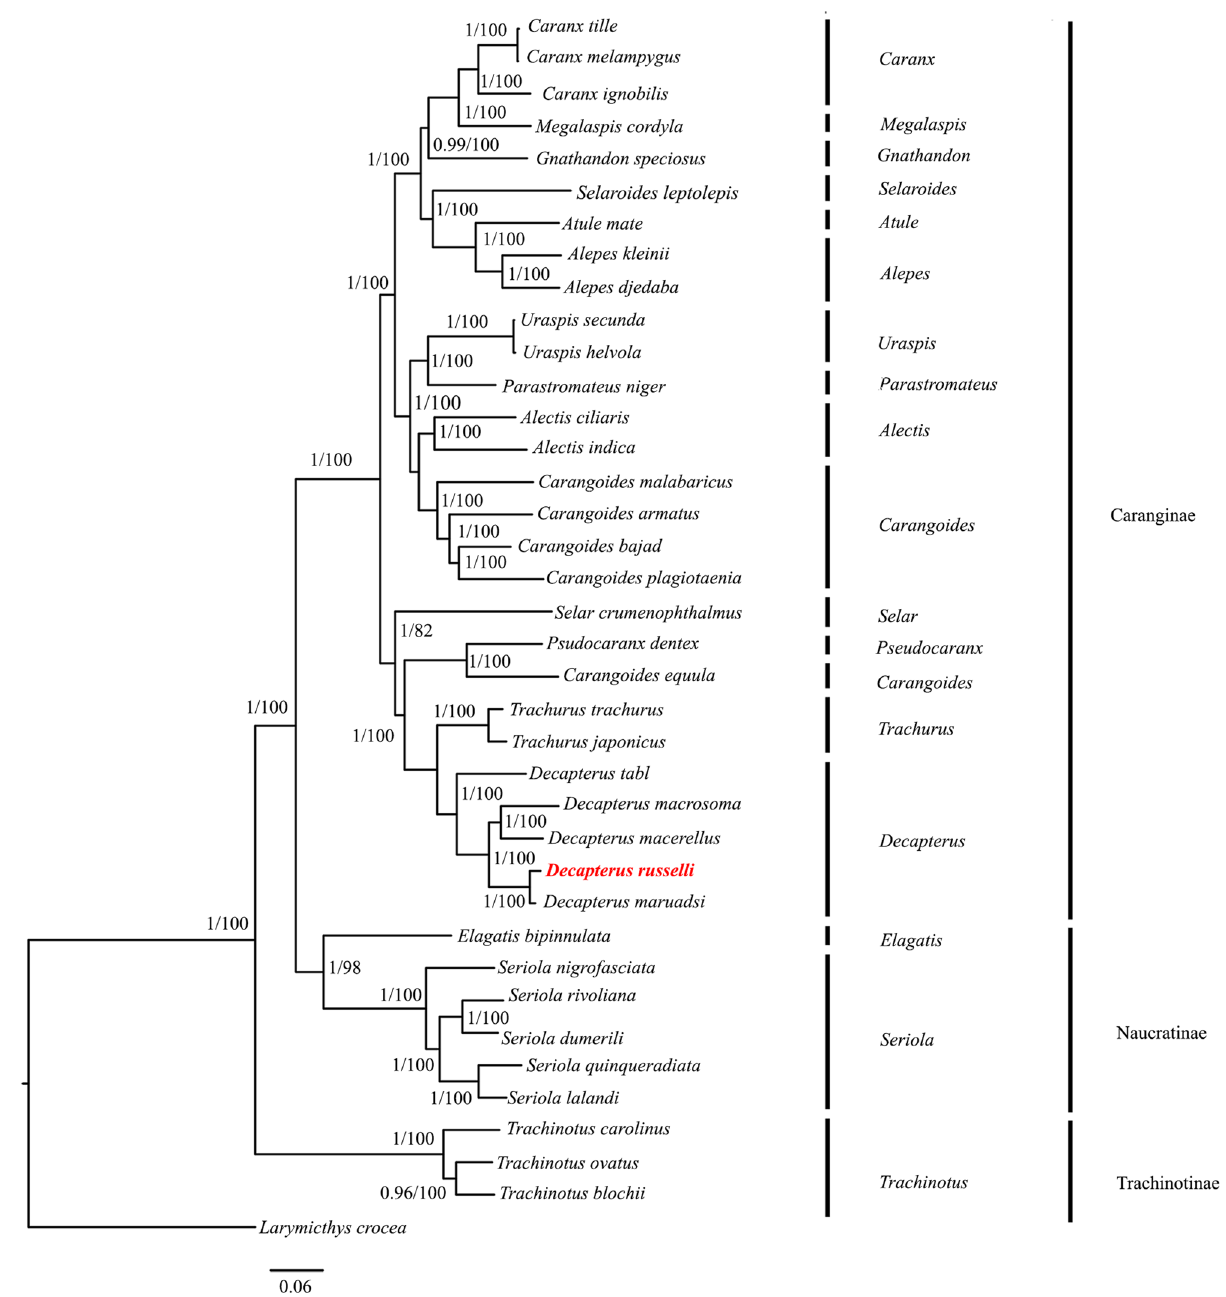
Figure 3. Phylogenetic tree inferred from the nucleotide sequences of 13 concatenated PCGs of 37 species of Carangidae. Bayesian posterior probabilities (left) and bootstrap support values (right) are superimposed with each node. The phylogenetic tree was generated by using MrBayes 3.2.7a 93